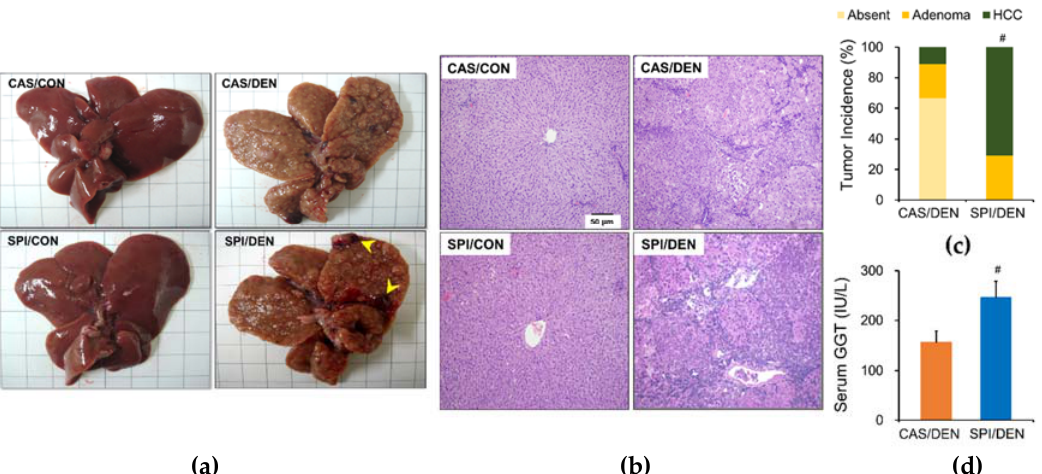
Figure 3. E ff ects of maternal diet on hepatocellular carcinoma (HCC) incidence and nodule development in DEN-treated male rat o ff spring. ( a ) Representative livers from control and DEN-treated rats. Regenerating nodules, early cancerous nodules, and malignant nodules with a diameter ≥ 3 mm (arrowhead) were detected on the surface of the liver. ( b ) Representative hematoxylin and eosin (H&E) stained liver sections from each group (magnification × 100). Photographs show the absence of HCC in CAS / CON, SPI / CON, and CAS / DEN groups and the presence of HCC in SPI / DEN group. ( c ) Liver cancer incidence based on histological examination. Incidence is expressed as percentage of the number of rats with designated tumor grade per total number of surviving rats. # Significantly di ff erent from the CAS / DEN group at p < 0.05 (by Mann–Whitney U test). ( d ) Serum γ -glutamyl transferase (GGT) activity. Results are expressed as means ± SEM (n = 7 or 9 / group). # Significantly di ff erent from the CAS / DEN group at p < 0.05 (by Student’s t -test).